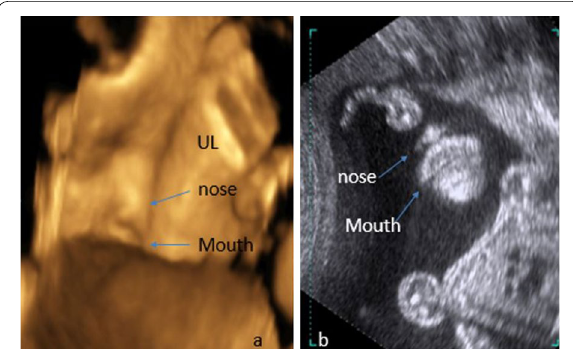
Fig. 5 Close proximity to upper limb; 31 weeks gestational age fetus shows close proximity of UL to fetal mouth and nose; some details from 4D image ( a ) and good details from 2D images ( b